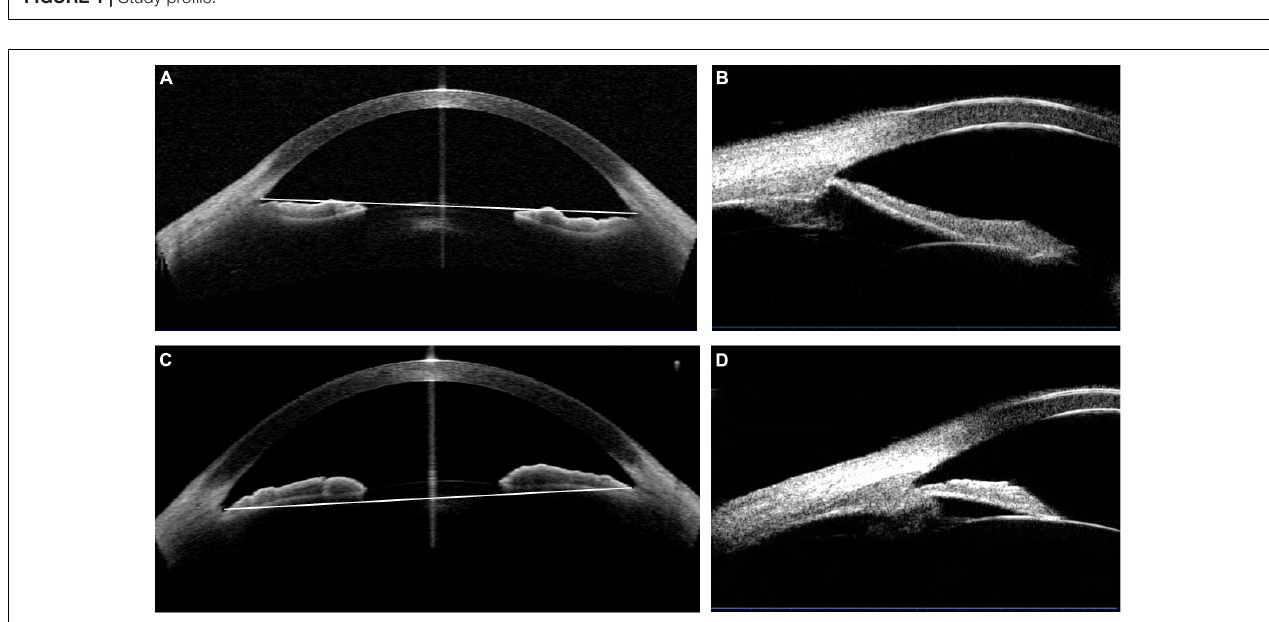
FIGURE 1 | Study profile.